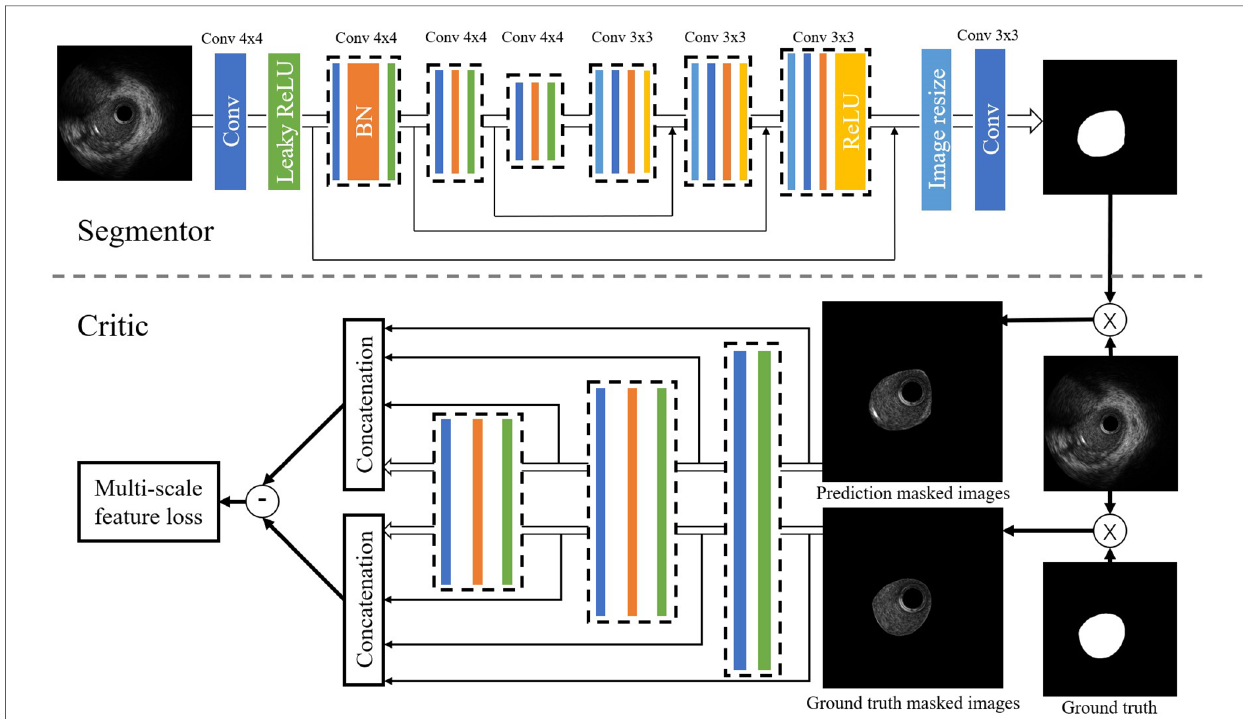
FIGURE 3 Structure of the SegAN. Segmentor uses the convolutional layer with kernel size 4 (cid:3) 4 and stride 2 for downsampling and performs upsampling by convolutional layer with kernel size 3 (cid:3) 3 stride 1. Skip connections are added between corresponding layers in the encoder and the decoder. The structure of the critic is similar to the encoder in the segmentor. Hierarchical features are extracted from multiple layers of C and used to compute the multi-scale L1